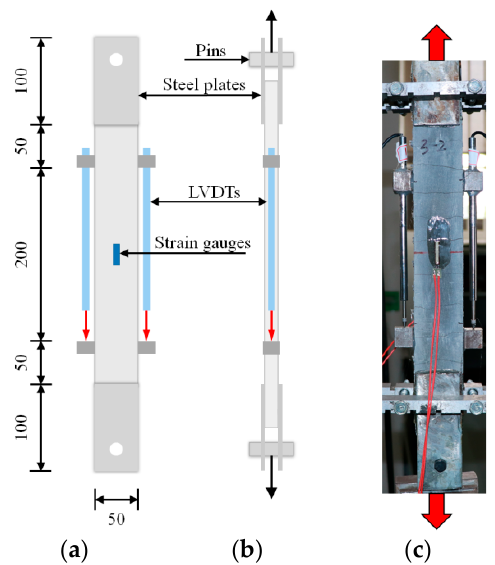
Figure 4. Test setup for tensile tests: ( a , b ) sketch, in mm; and ( c ) in-site